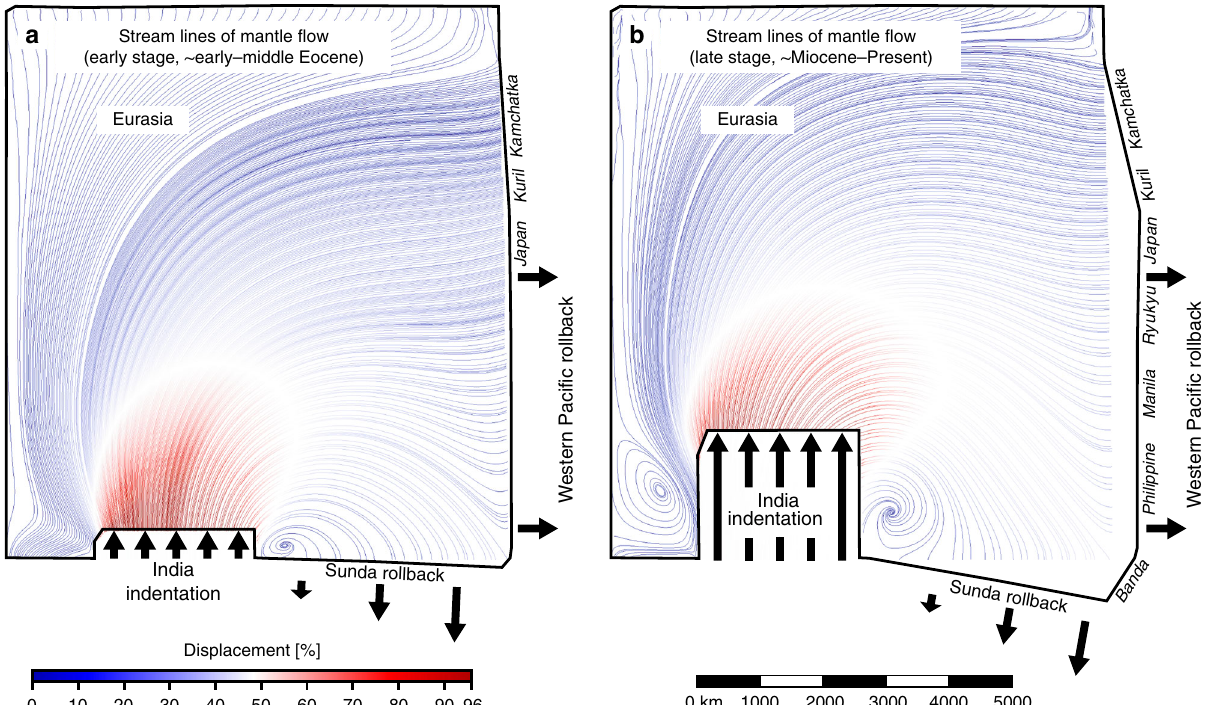
Fig. 7 Top views of experiment I-R MO showing the horizontal mantle streamline pattern. The streamline pattern illustrates the general fl ow pattern at the lithosphere – asthenosphere boundary and in the ductile lithospheric mantle and results from Indian indentation (continental subduction hinge and slab advance) and Western Paci fi c and Sunda subduction zone rollback (hinge and slab retreat). a Horizontal mantle fl ow pattern for an early stage of the experiment (corresponding to the early – middle Eocene). b Horizontal mantle fl ow pattern for a late stage of the experiment (corresponding to the Miocene – Present). Note that I-R MO has an R = 0.62 and no brittle top